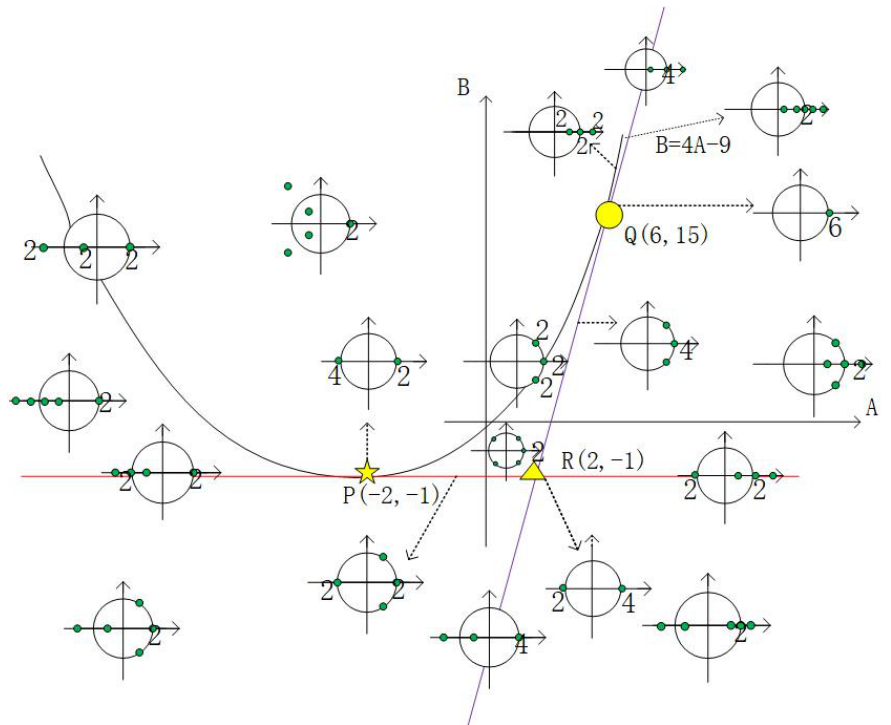
Figure 1. Topological types of periodic orbits in the plane of parameters: the green point in each subfigure represents a multiplier, and the number near the point is its multiplicity.